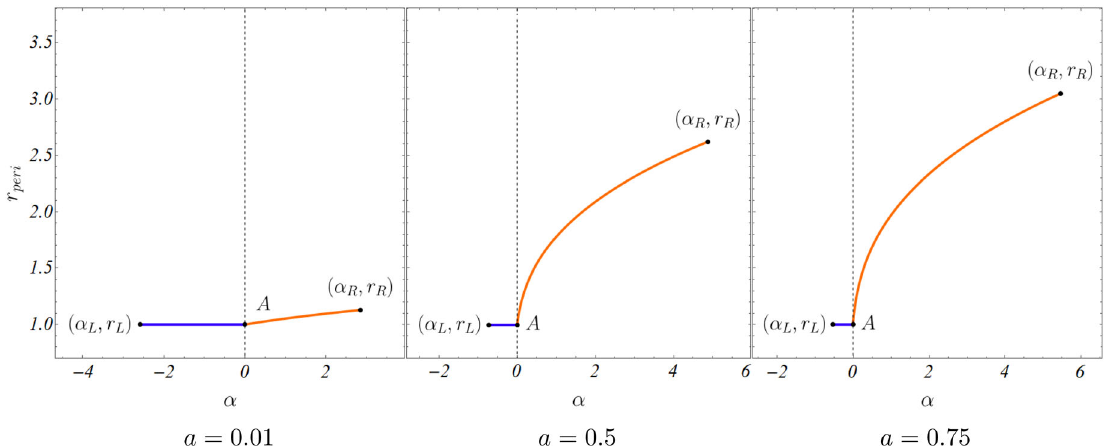
Fig. 3 Dependence of the impact parameter α on the radial distance along the shadow boundary for the redshift function N = exp ( − r 0 The impact parameters of the left- and rightmost shadow edges are denoted by α L and α R , respectively, while the point A represents the